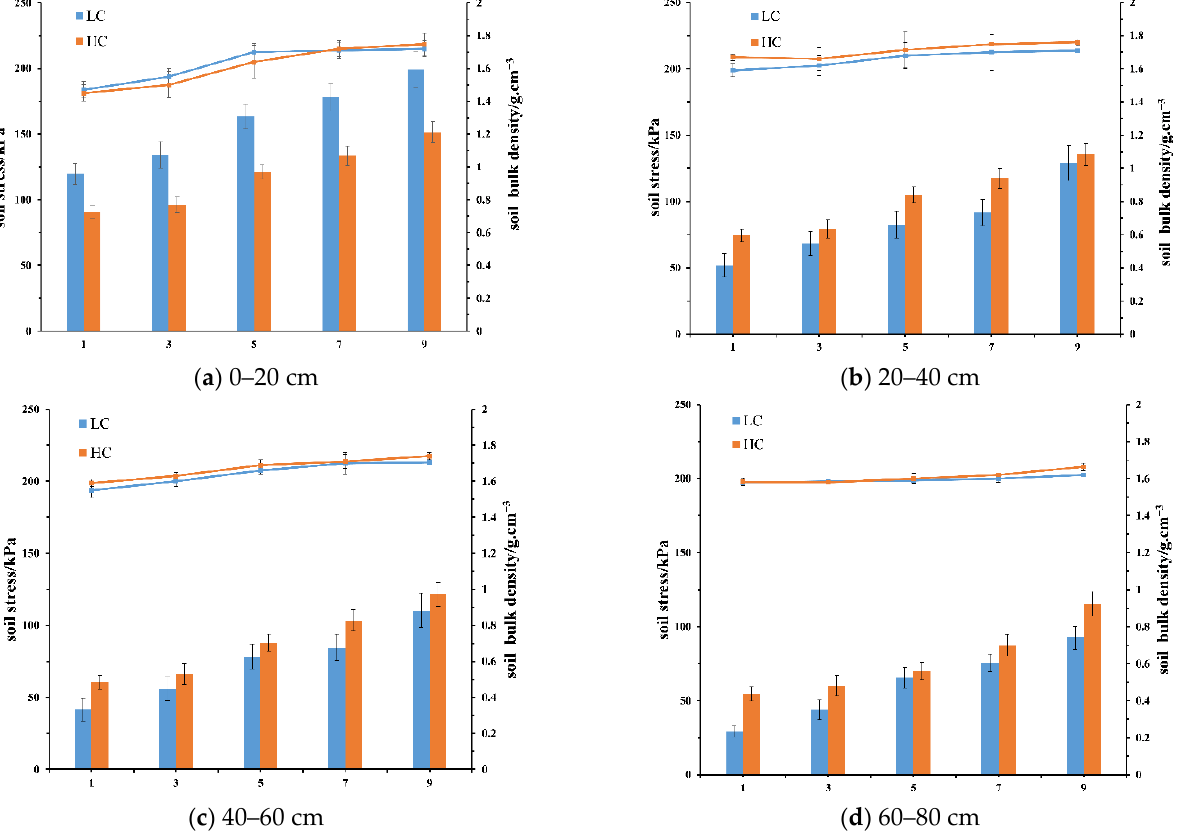
Figure 4 . Effect of load and number of passes of the tractor on the spatial distribution of soil stress and soil bulk density . ( a ) represents the depth of the 0 – 20 cm soil layer, ( b ) represents the depth of and soil bulk density. ( a ) represents the depth of the 0–20 cm soil layer, ( b ) represents the depth of the 20 – 40 cm soil layer; ( c ) represents the depth of the 40 – 60 cm soil layer, ( d ) represents the depth the 20–40 cm soil layer; ( c ) represents the depth of the 40–60 cm soil layer, ( d ) represents the depth of the 60 – 80 cm soil layer; LC — tractor with low mass, John Deer 280 (John Deere, New York, the of the 60–80 cm soil layer; LC—tractor with low mass, John Deer 280 (John Deere, New York, NY, United States) ; HC — tractor with high mass, LOVOLM904 (Weizhai Leiwo Heavy Industry Co. LTD, USA); HC—tractor with high mass, LOVOLM904 (Weizhai Leiwo Heavy Industry Co. Ltd., Weifang, Weifang, China).